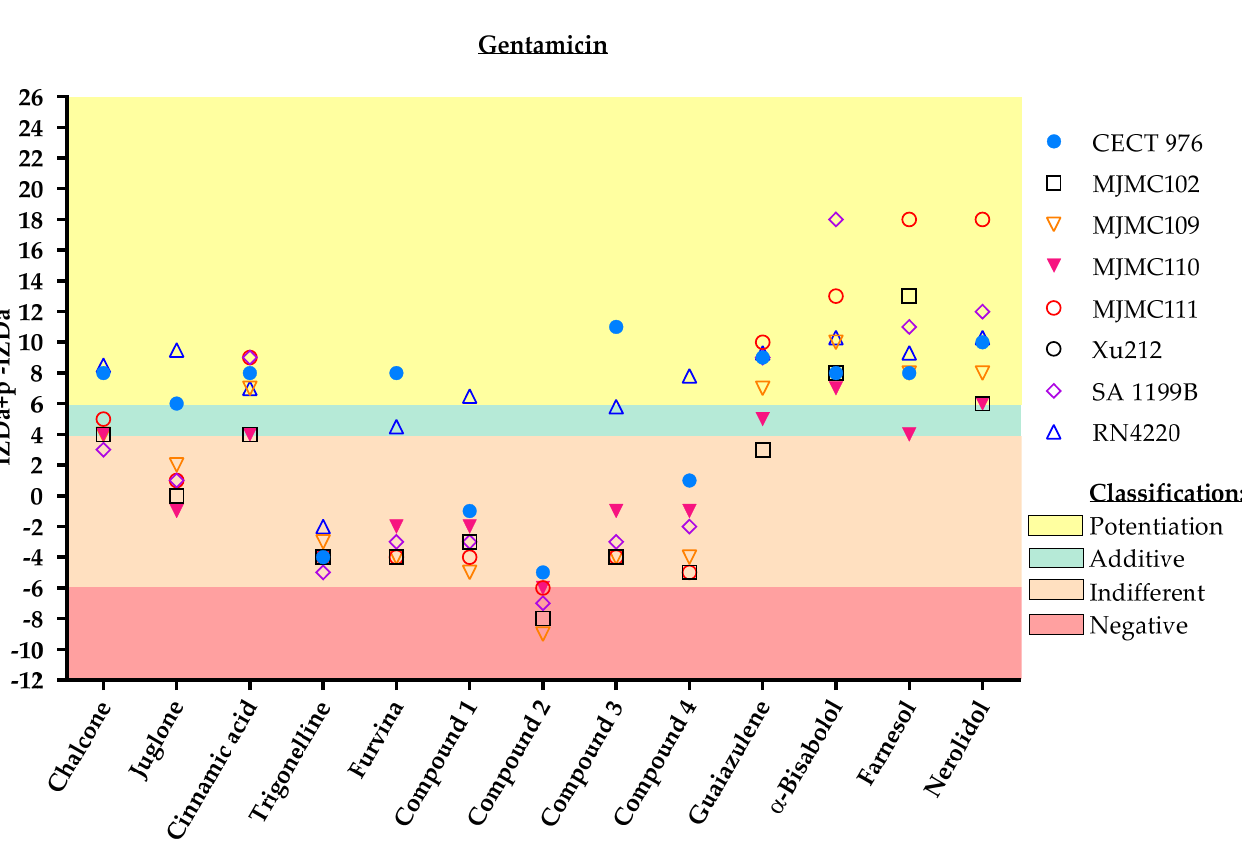
Figure 5. IZD values (mm) and respective classification according to the combined application of the selected phytochemicals and gentamicin against the eight different S. aureus strains. The effect of dual combinations of antibiotics and phytochemicals was classified as potentiation when IZDa+p –IZDa ≥ 6 mm (yellow zone), additive when 6 mm > IZDa+p–IZDa ≥ 4 mm (green zone), indifferent when 4 mm > IZDa+p–IZDa > − 6 mm (light pink zone) and negative when IZDa+p–IZDa ≤ − 6 mm (dark pink zone), where IZD corresponds to the inhibition zone diameter, a = antibiotic and p = phytochemical. Compound 2 , a nitrovinylfuran derivative, induced total growth inhibition against the RN4220 strain. More detailed information about the interactions is given in the Supplementary Materials, including some geometric shapes that might be overlayed on the graph (Table S1).